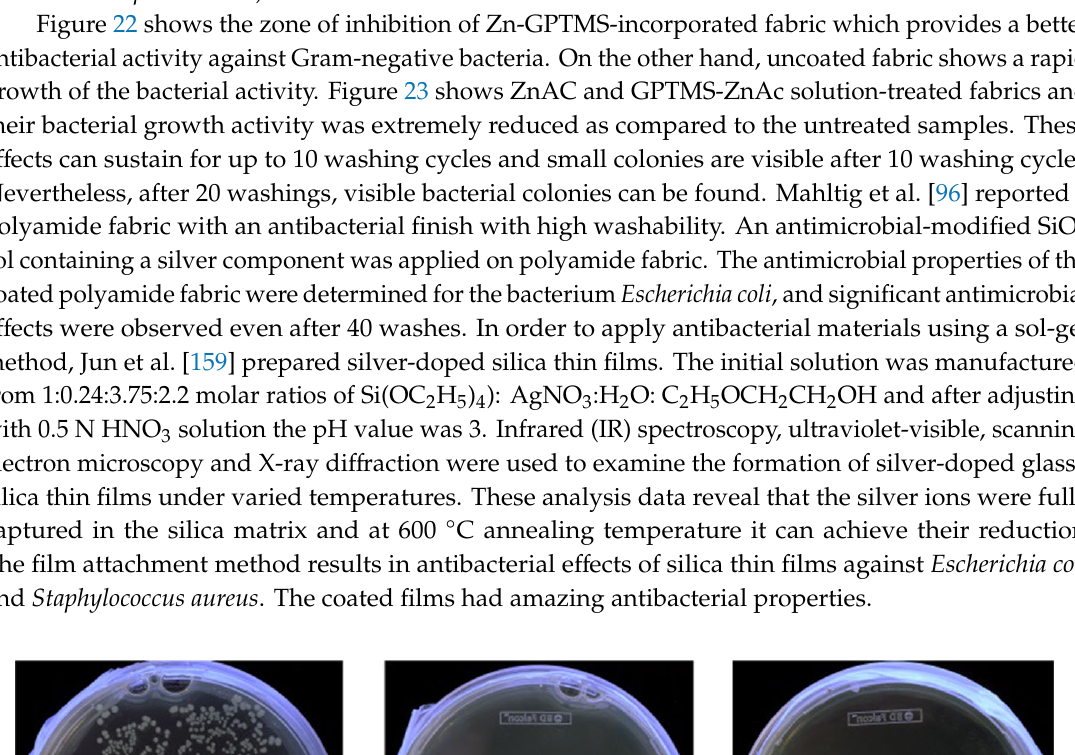
Figure 23. ( a ) Zone of inhibition ( E. coli ) on the 3% Zinc acetate on the number of CFU after 24 h. unwashed sample; ( b ) after 1 washing cycle; ( c ) 5 washing; ( d ) 10 washing cycles and ( e ) 20 washing cycles (Reproduced from [158], with kind permission of Elsevier).